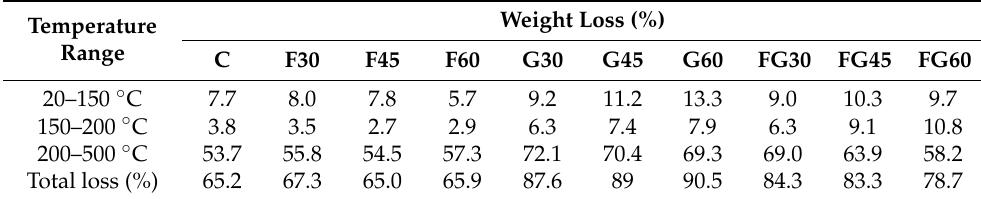
Table 3. Weight loss of all samples at different stages of